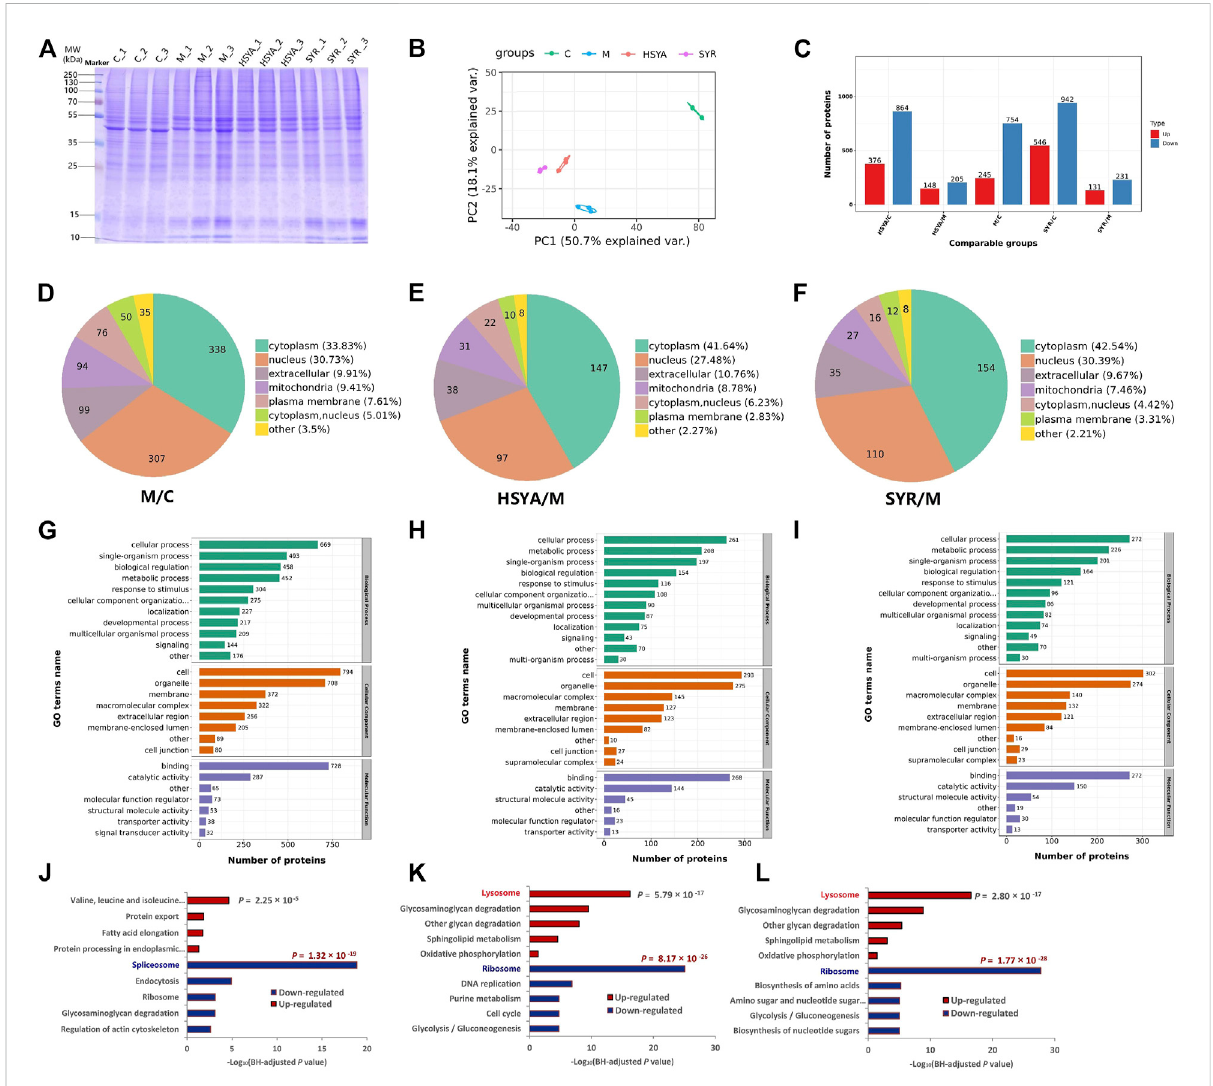
FIGURE 6 (A) Represents the SDS-PAGE analysis for the total proteins of C, M, HSYA and SYR group. (B,C) show the PCA analysis score plot and the differenceproteinsnumbers,respectivelyforMvs.C,HSYAvs.MandSYRvs.Mgroups. (D – F) showthedifferenceexpressionproteinslocationinthe comparisons for M vs. C, HSYA vs. M and SYR vs. M groups, respectively. (G – I) show the GO annotation results of the difference expression proteins for M vs. C, HSYA vs. M and SYR vs. M groups, respectively. (J – L) show the downregulation and upregulation pathways for M vs. C, HSYA vs. M and SYR vs. M groups,